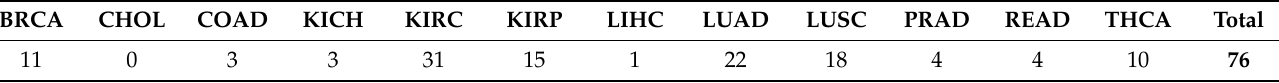
Table 3. Summary of survival analysis regarding the number of prognostic lncRNAs for each of the 12 TCGA cancer types.